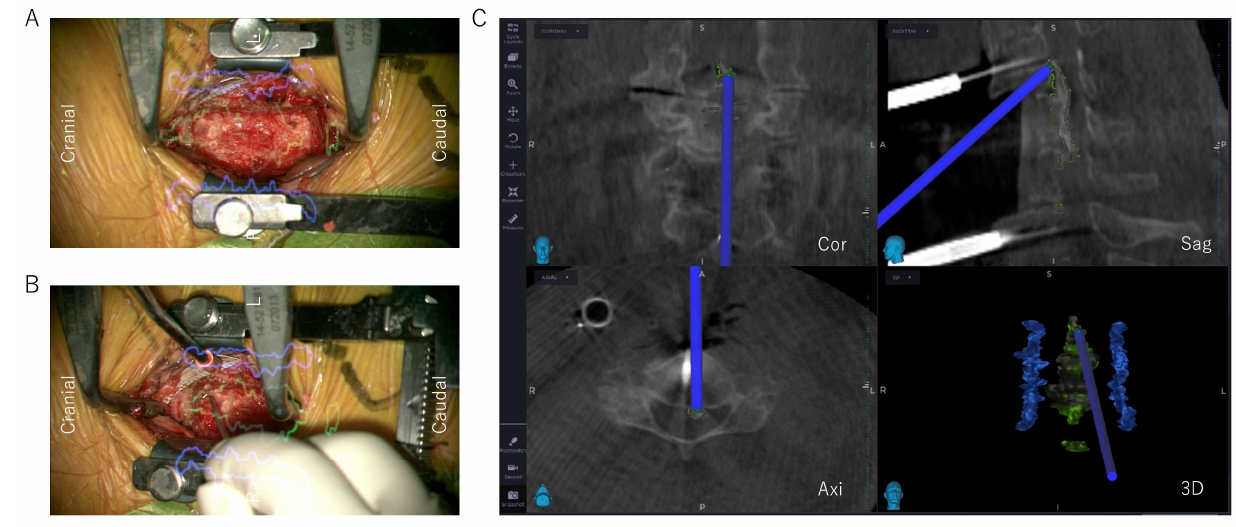
Figure 3. AR microscope view and navigation monitor of the ADF using the floating method. ( A ) Outline of the OPLL (yellow-green line) and vertebral arteries (blue line) visualized under the AR microscope view. ( B ) AR microscope view of a completed fl oating OPLL. The ossi fi cation edge (yel- low-green outline in AR view) is completely decompressed, and the ossi fi cation is fl oating. ( C ) Nav- igation monitor after completed fl oating OPLL, with con fi rmation that the top ends of the ossi fi ca- tion have been thinned and released. ADF, anterior decompression and fusion; AR, augmented re- ality; OPLL, ossi fi cation of the posterior longitudinal ligament.